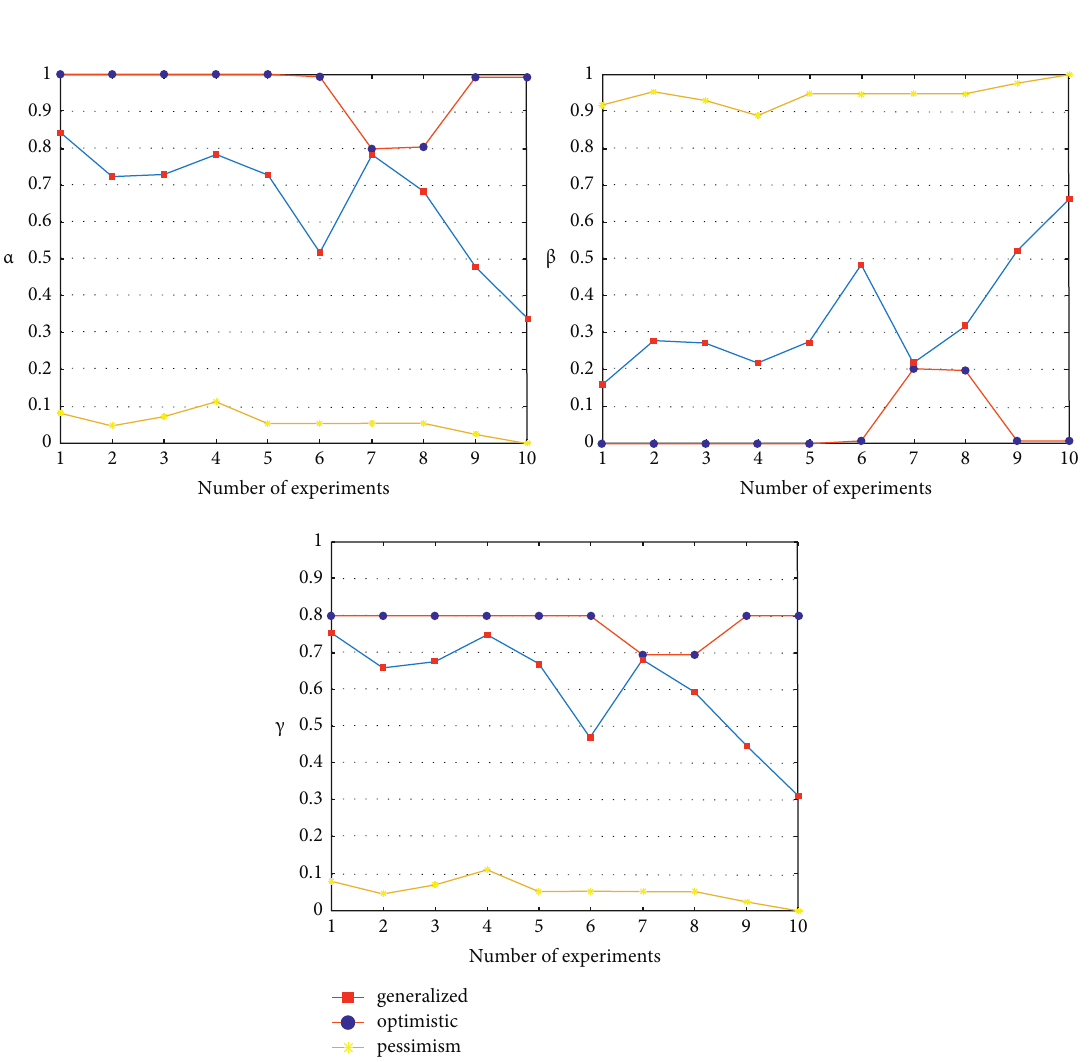
Figure 2: Uncertainty measurement of weighted multigranulation model for “own-data